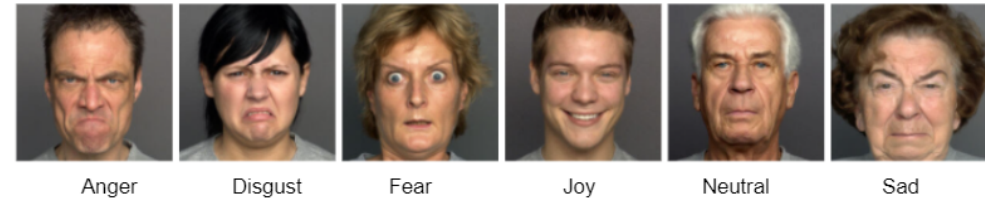
Figure 6. FACES samples.